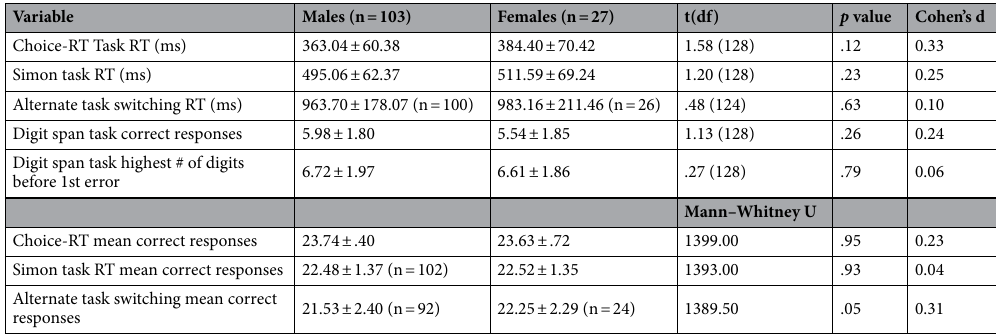
Table 2. Differences between the performance of males and females in all the dependent